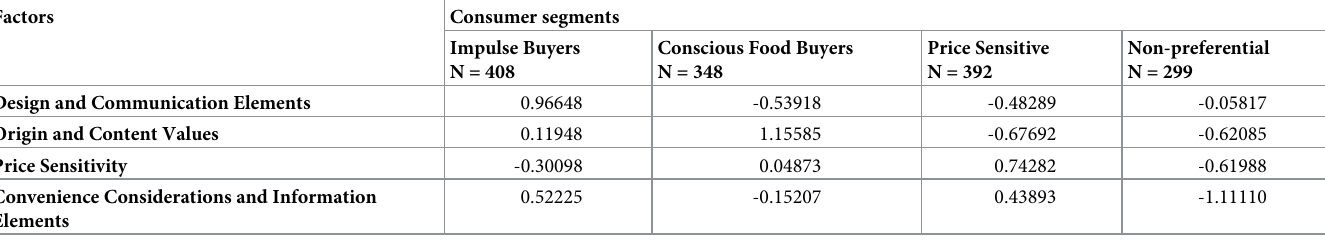
Table 3. Consumer segments formed on the basis of food purchasing